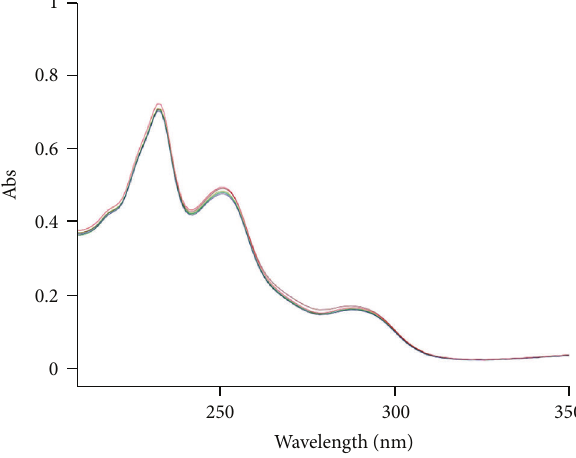
Figure 3: UV spectra of unirradiated and gamma irradiated